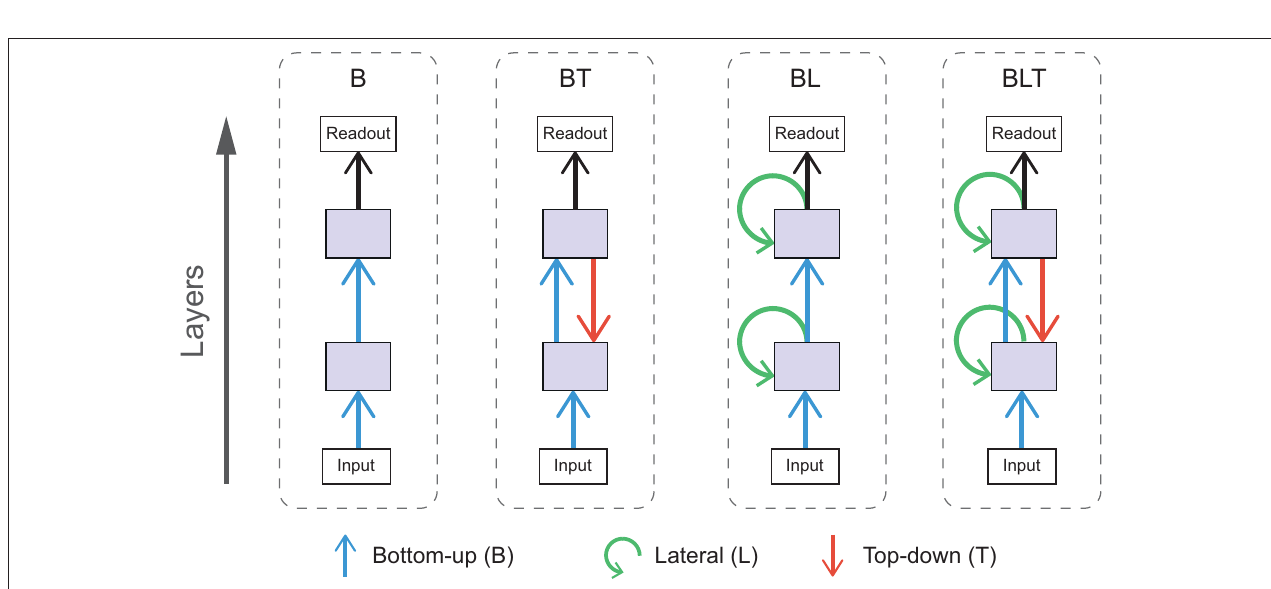
FIGURE 2 | High resolution examples from the stimulus sets used in these experiments. The top row shows digit debris stimuli for each of the three conditions tested here, with 10, 30, and 50 fragments. The bottom row shows digit clutter stimuli with 3, 4, and 5 digits.